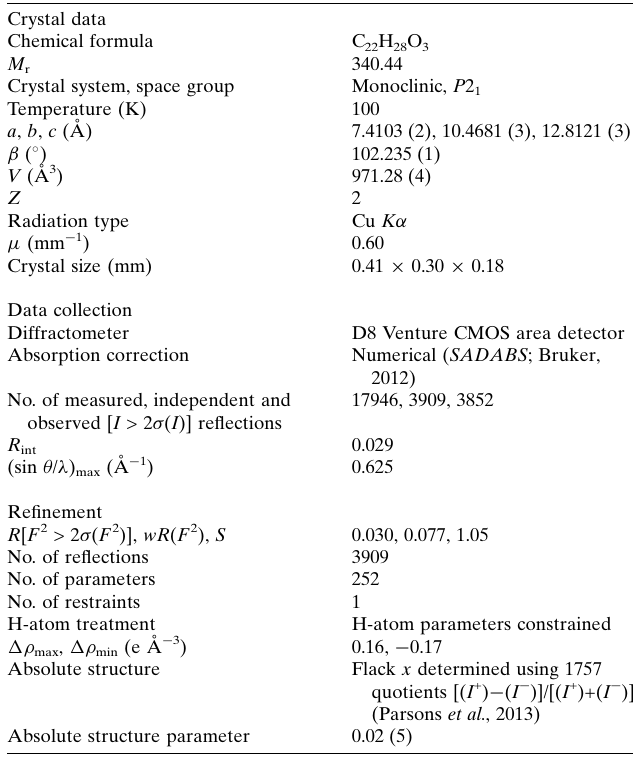
Crystal data Chemical